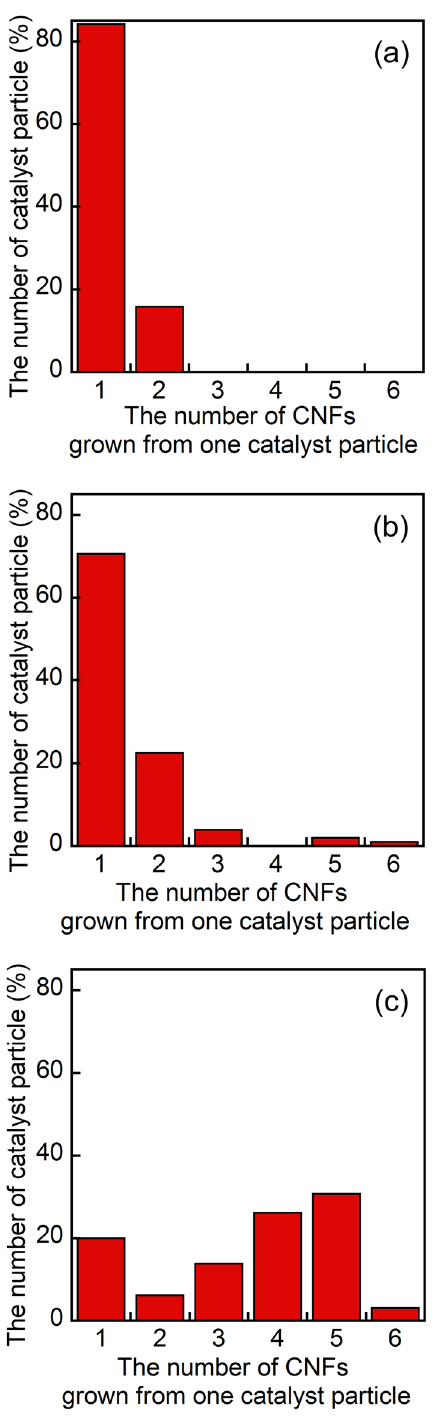
Fig. 7 The histograms were obtained from the SEM images in Fig. 6. Ni8Cu2/O-dia. catalysts were used and grown at the temper- ature of 600 °C. The growth duration is a 10 min, b 30 min, and c 60 min